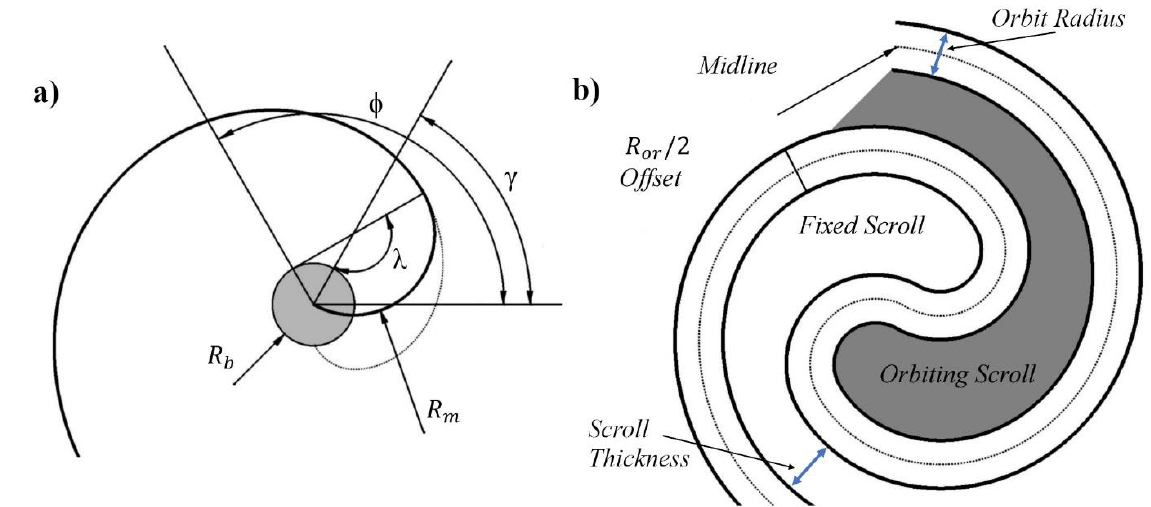
Figure 1. Complete meshing profiles (CMP) midline angles and parameters. ( a ) midline angles; ( b ) main geometrical